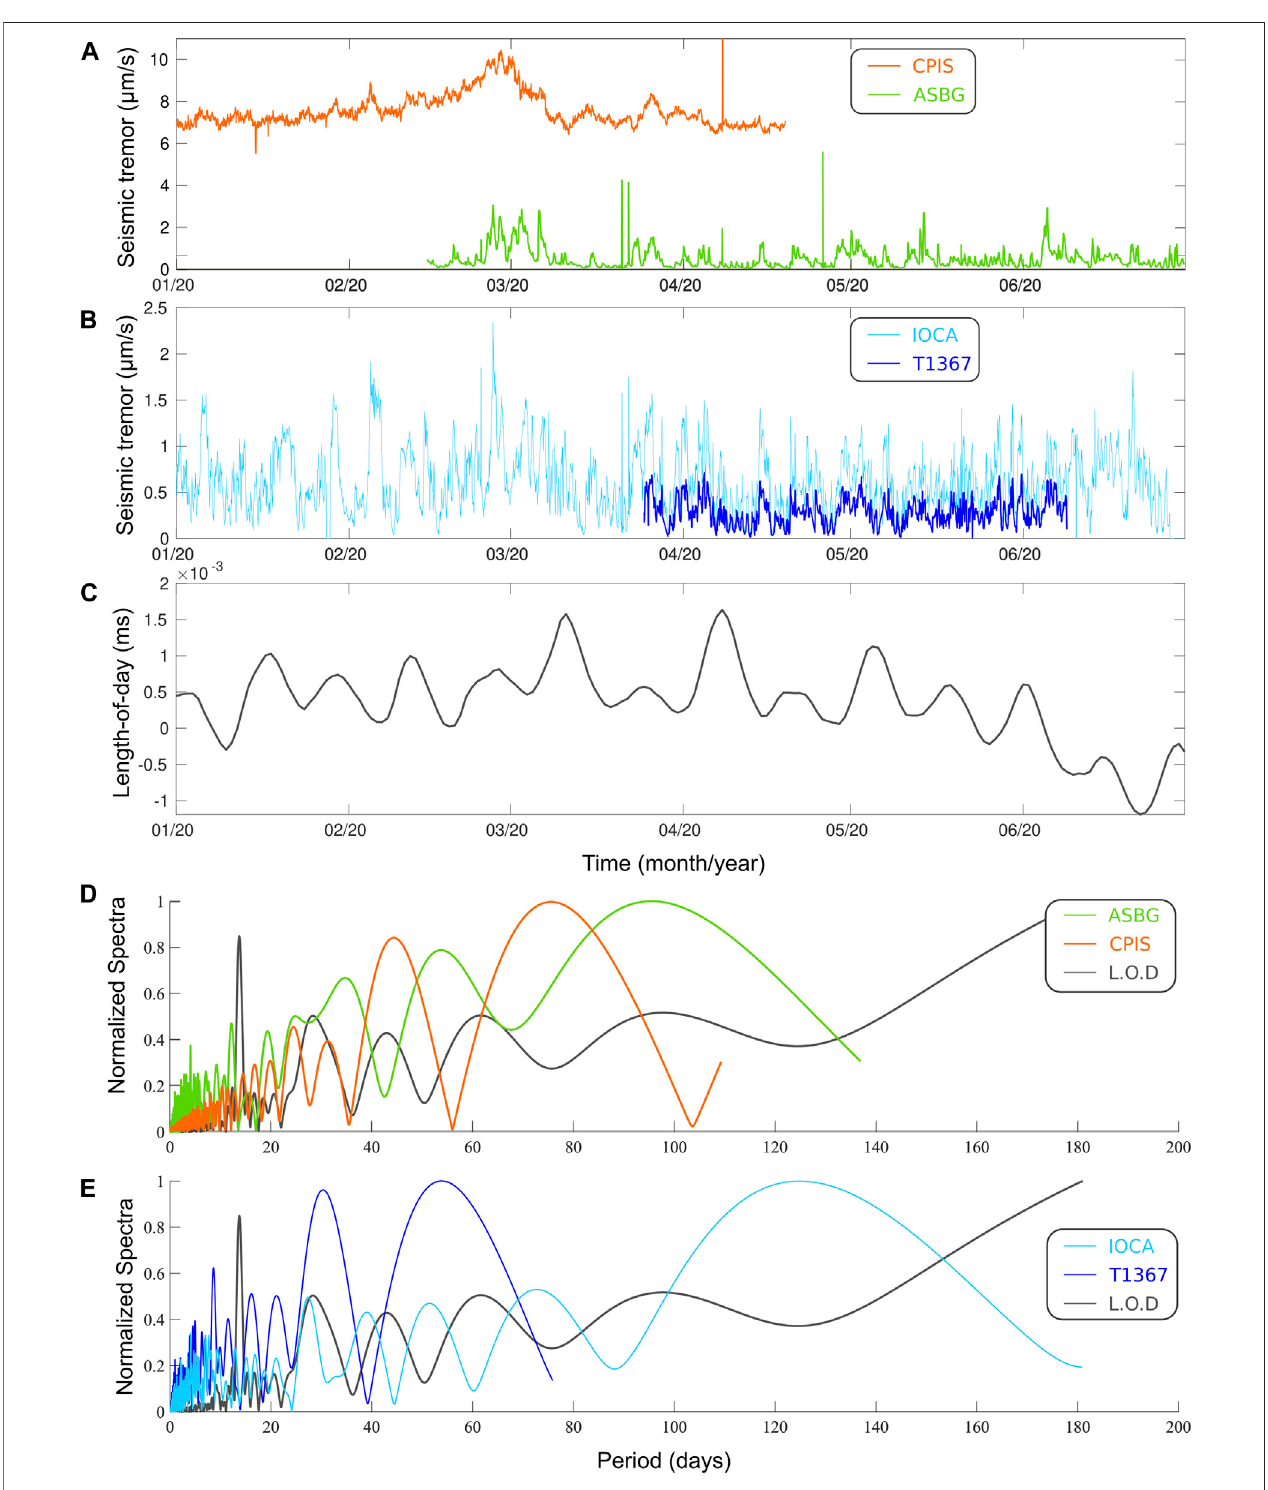
FIGURE 2 | RMS amplitude of the seismic tremor at Campi Flegrei (A) and Ischia island (B) . Length-of-day (l.o.d) (C) and their normalized spectra in the two lower panels (D – E) .